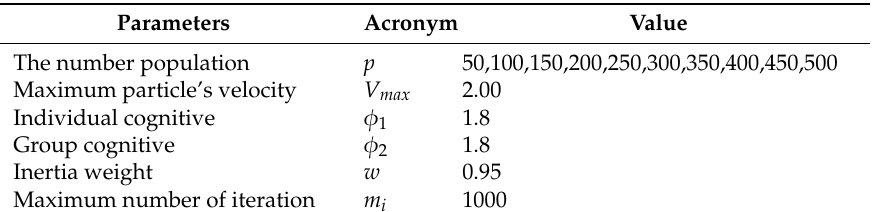
Table 2. The optimal values of the PSO algorithm in this study.